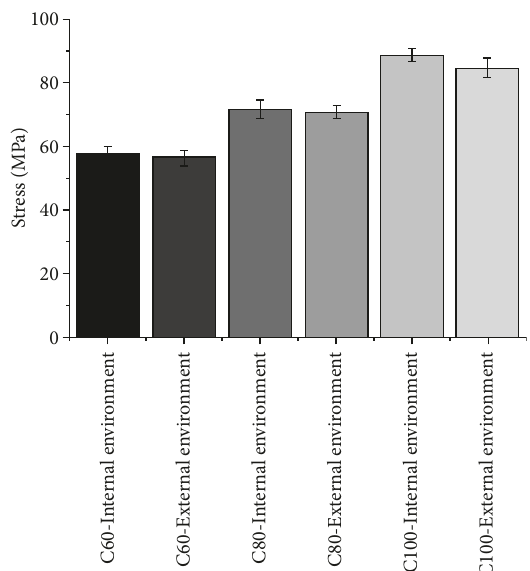
Figure 9: Standard deviation of peak